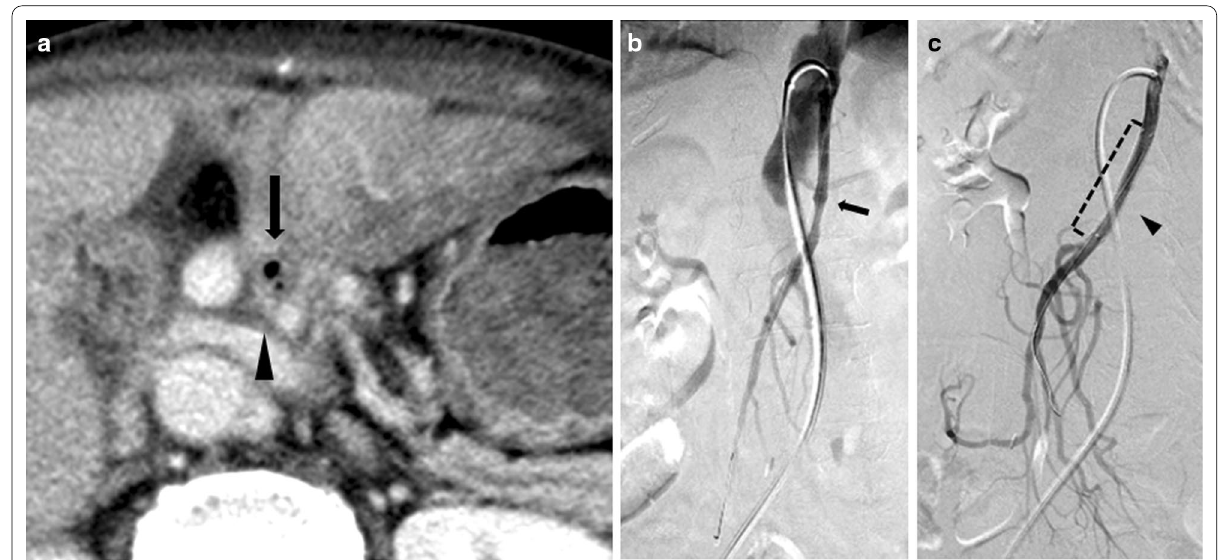
Fig. 3 Evaluation using axial equilibrium phase contrast-enhanced computed tomography (CECT). a Axial equilibrium phase CECT shows the collection of gas (black arrow), an aneurysm of the superior mesenteric artery (black arrowhead) and the stomach filling with contrast fluid. b Superior mesenteric arteriography shows an aneurysm (black arrow), but extravasation was uncertain. c Arteriography after endovascular repair shows resolution of the aneurysm and preserved SMA blood flow through the covered stent (black arrowhead and dotted